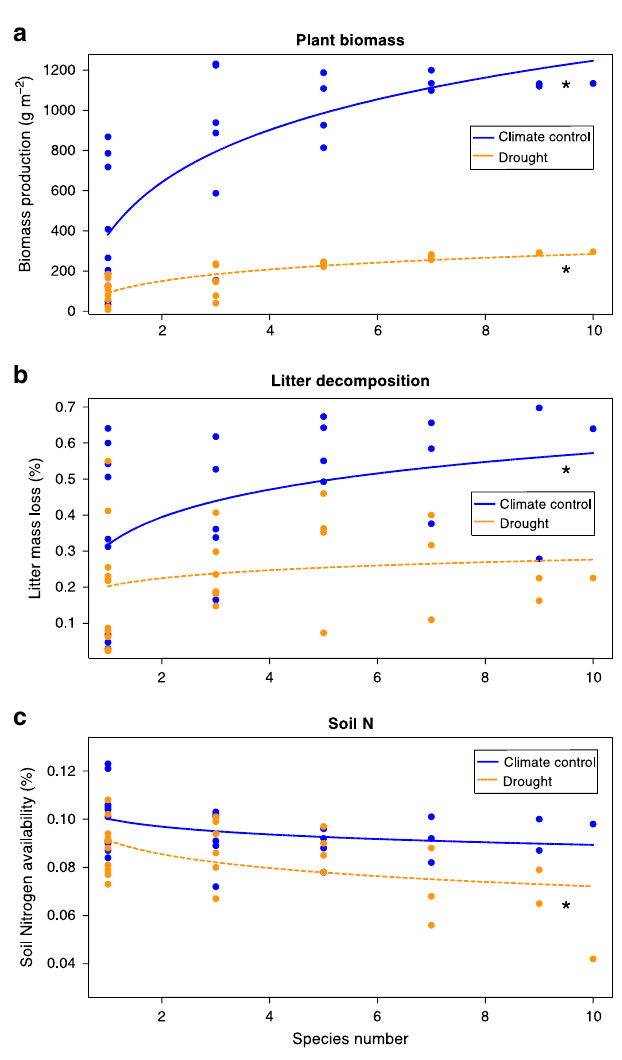
Fig. 1 Observed effects of species diversity on biomass production, litter decomposition, and soil nutrient availability. Panels from a – c include information of biomass production, litter decomposition, and soil N availability respectively. Total Soil N is shown here as an example of soil nutrient content but very similar relationships were observed for the other soil elements measured (C, P, Ca, Mg, and K). Blue lines and points represent the communities under control climate conditions and orange dashed lines and points show the same communities under drought conditions. Nonlinear instead regressions fi tted the data better. Signi fi cant regressions at P < 0.05 are represented with an